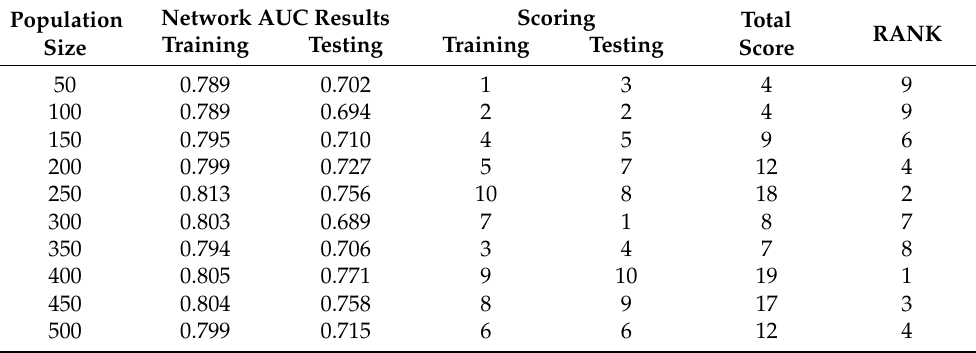
Figure 10. The ROC curves plotted for the (i) training and (ii) testing datasets in BSAMLP algorithm. Table 4. The Results of AUC for different BSAMLP proposed structure in predicting the landslide susceptibility